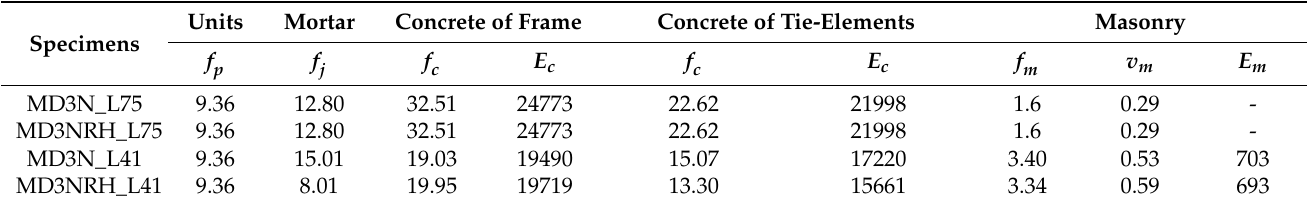
Table 2. Material properties (MPa).